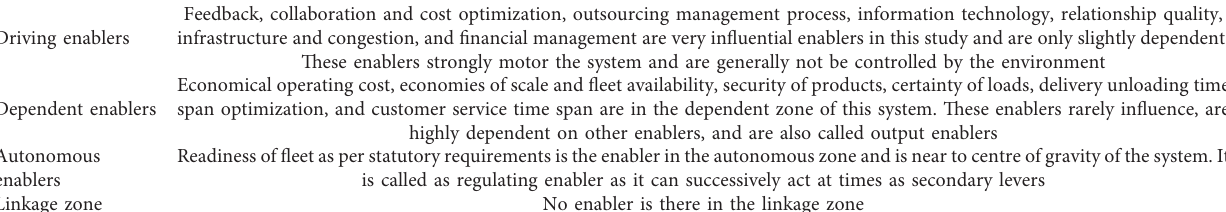
Figure 7: MICMAC analysis. Table 9: Different enablers in driving power x dependence graph.